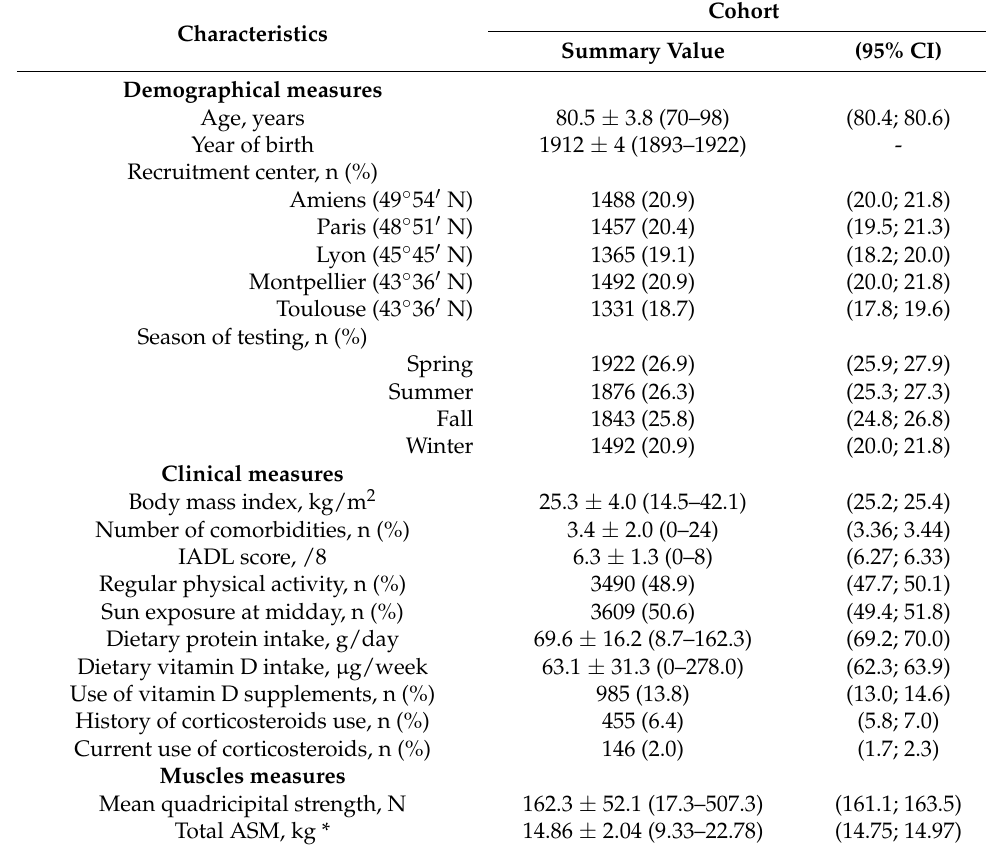
Table 1. Summary of the participants’ characteristics ( n =